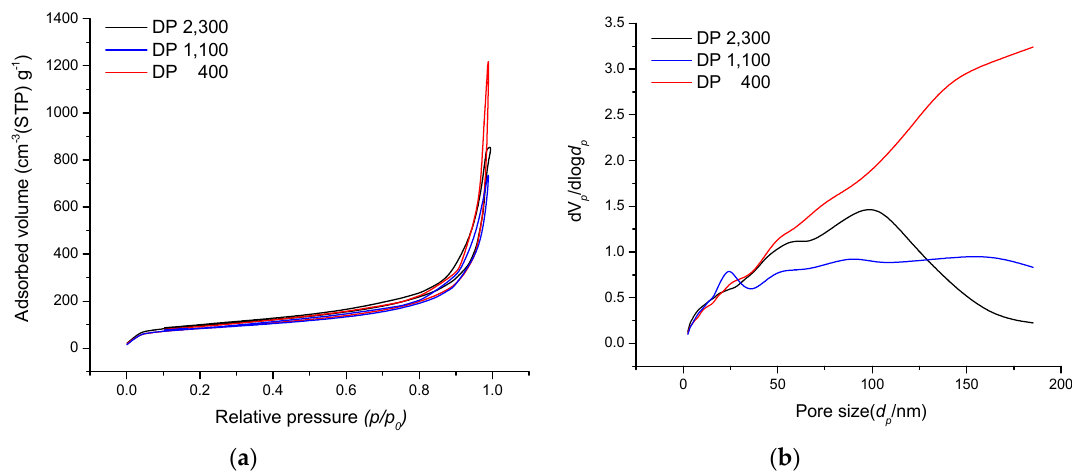
Figure 8. Nitrogen adsorption–desorption isotherms ( a ) and pore size distribution ( b ) of cellulose aerogels with different DPs.